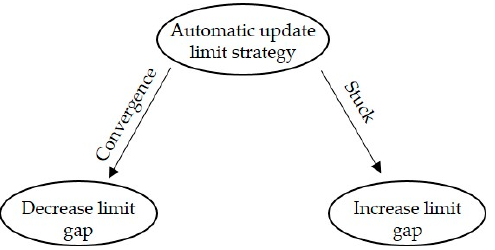
Scheme 1. Impact of the automatic update limit strategy on the limit gap during the Levenberg– Marquardt algorithm (LMA)